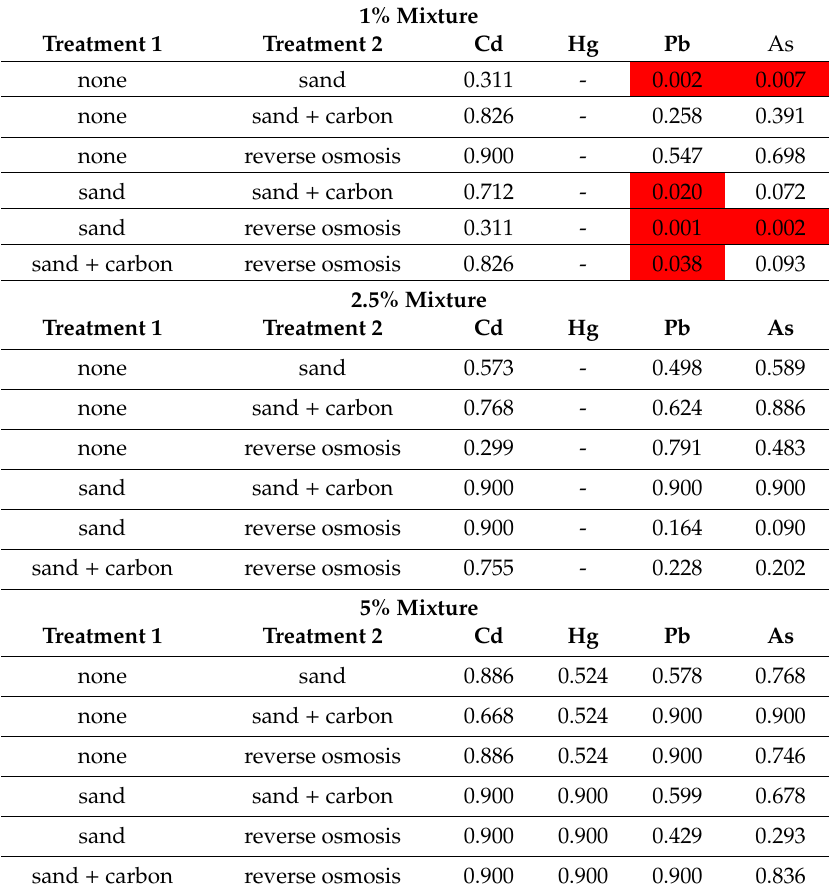
Table 3. Significant di ff erences between methods for each metal were calculated using Tukey HSD method and the p -values are presented for each treatment comparison. Significant di ff erences ( p < 0.05) are highlighted in red for convenience.